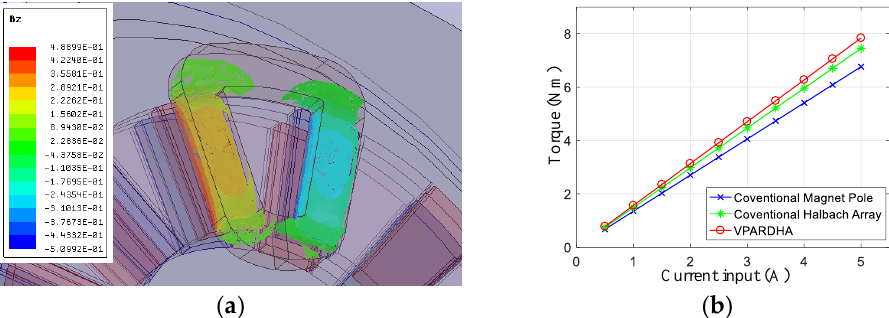
Figure 12. 3-D FEM validation with armature reaction field: ( a ) Flux density distribution within the coil; ( b ) Output torque comparison.